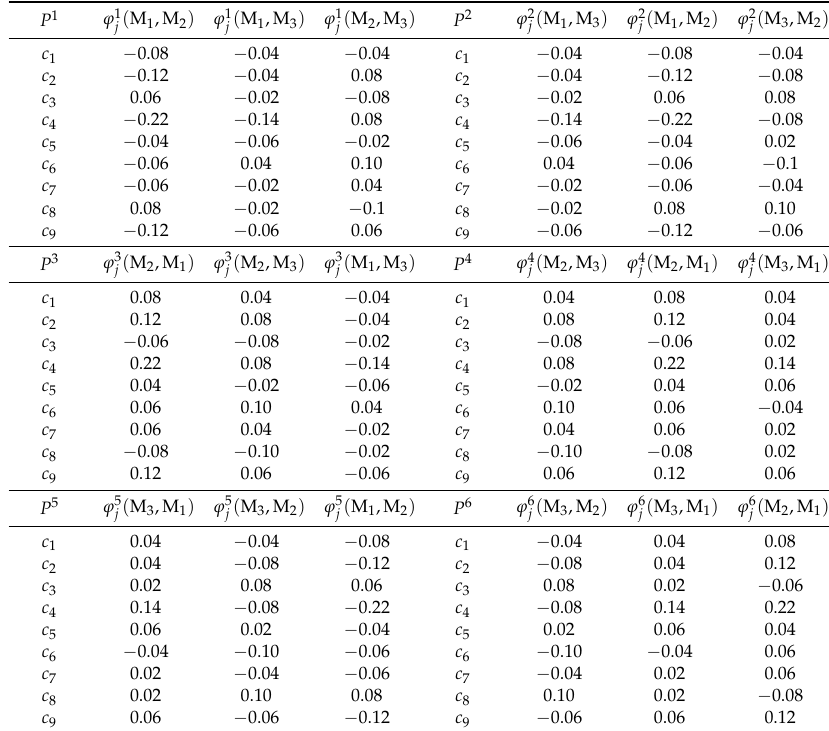
Table 3. The concordance/discordance index.